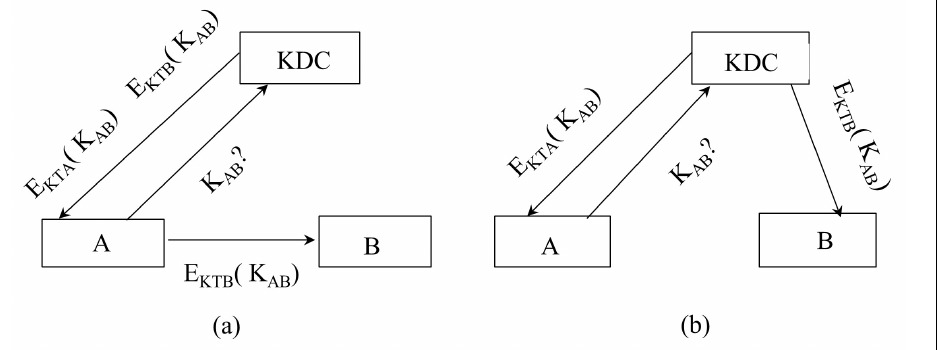
Figure 2 – Models of the cryptographic key delivery by the Key Distribution Center Рис. 2 − Модели передачи криптографических ключей через